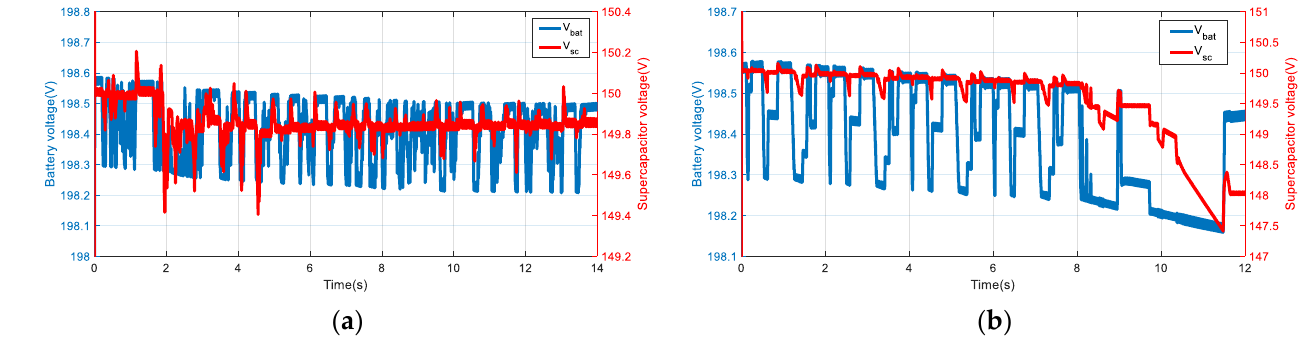
Figure 14. The voltages curves of battery and supercapacitor: ( a ) UDDS cycle; ( b ) NEDC cycle